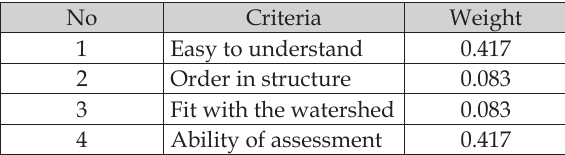
Table 4. The weight of criteria based on AHP